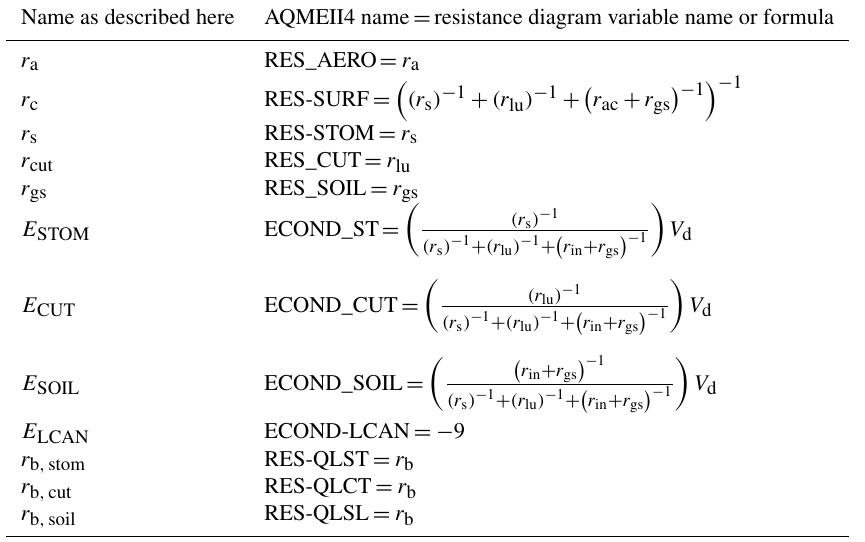
Table B7. AQMEII4-reported gaseous deposition variables corresponding to the COSMO-MUSCAT resistance model of Fig.